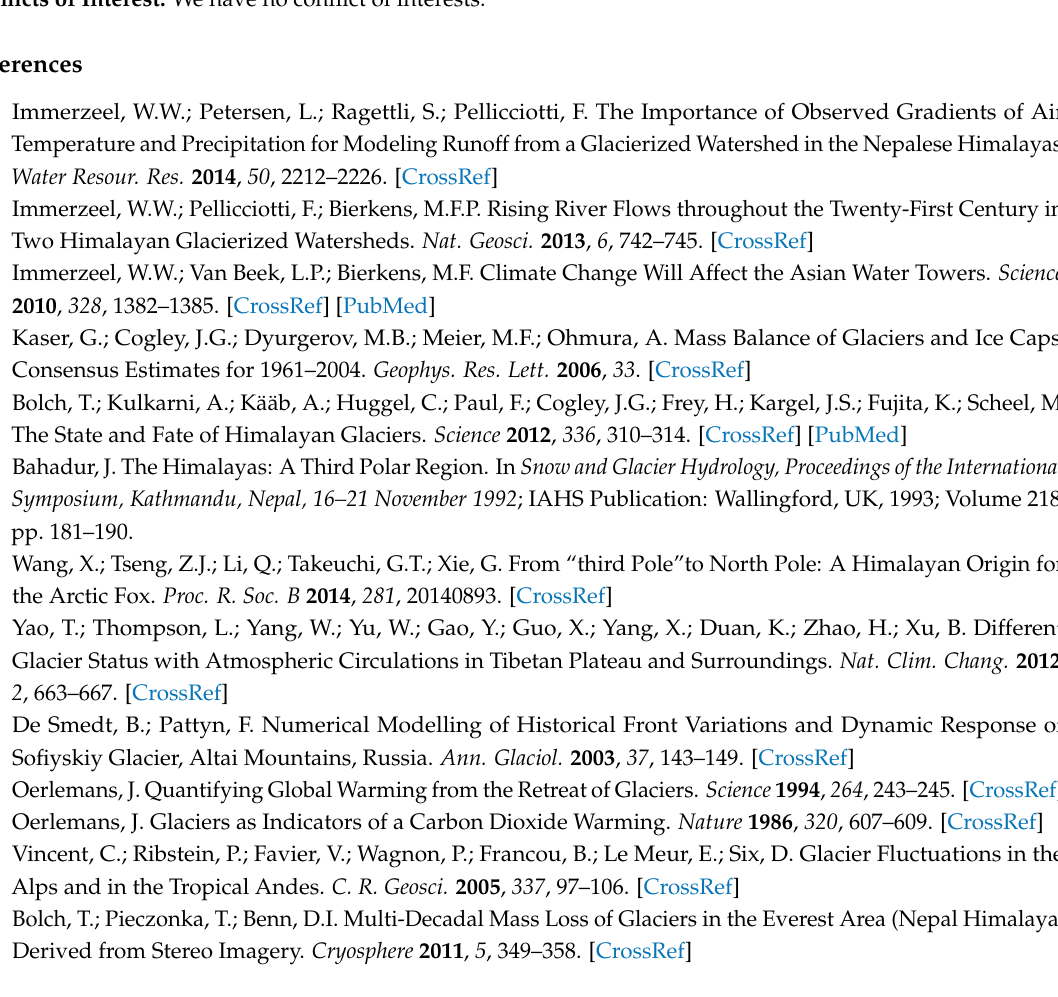
Figure S1: Annual mass balance (dots) of Yala Glacier from 2011 to 2017 as a function of altitude derived from the field measurements, Table S1: Total contribution of energy balance components to the surface melting at various stake locations on Yala Glacier for the period of 5 June 2012–13 October 2012 (131 days), 8 May 2013–19 November 2013 (195 days) and 5 May 2014–15 November 2014 (196 days), Table S2: Mean meteorological variables measured at Yala base camp AWS (5060 m a.s.l.) on Yala Glacier for the period June 2012–October 2012, May 2013–November 2013 and May 2014–November